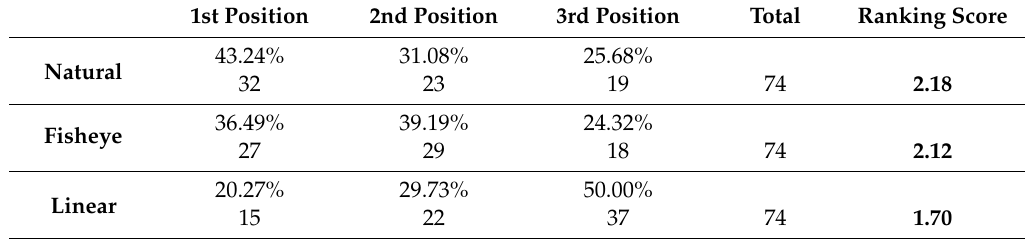
Table 1: For each of the three photographs (Natural, Fisheye and Linear), the table shows: in the first raw the absolute percentage of respondents that selected each answer choice; and in the second raw the total frequencies reported for each answer choice. The total responses column reports the total answers collected for each answer choice. The ranking score column lists for each photograph the Total Index of Preference, calculated by summing the weighted ranking for each answer choice. 1st Position 2nd Position 3rd Position Total Ranking Score 43.24% 31.08% 25.68% Natural 32 23 19 74 2.18 36.49% 39.19% 24.32% Fisheye 27 29 18 2.12 20.27% 29.73% 50.00% Linear 15 22 37 74